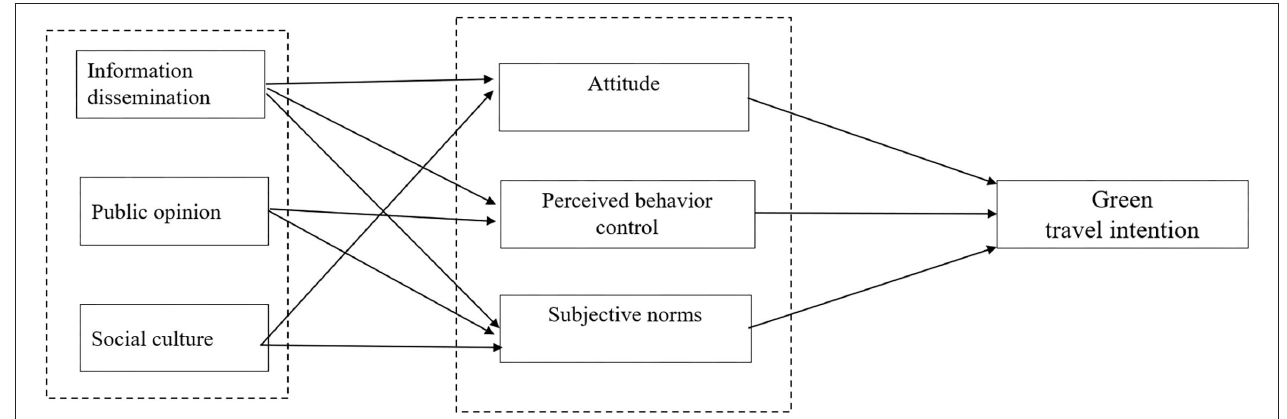
FIGURE 4 | Theoretical model of the impact of social propaganda policies on green travel